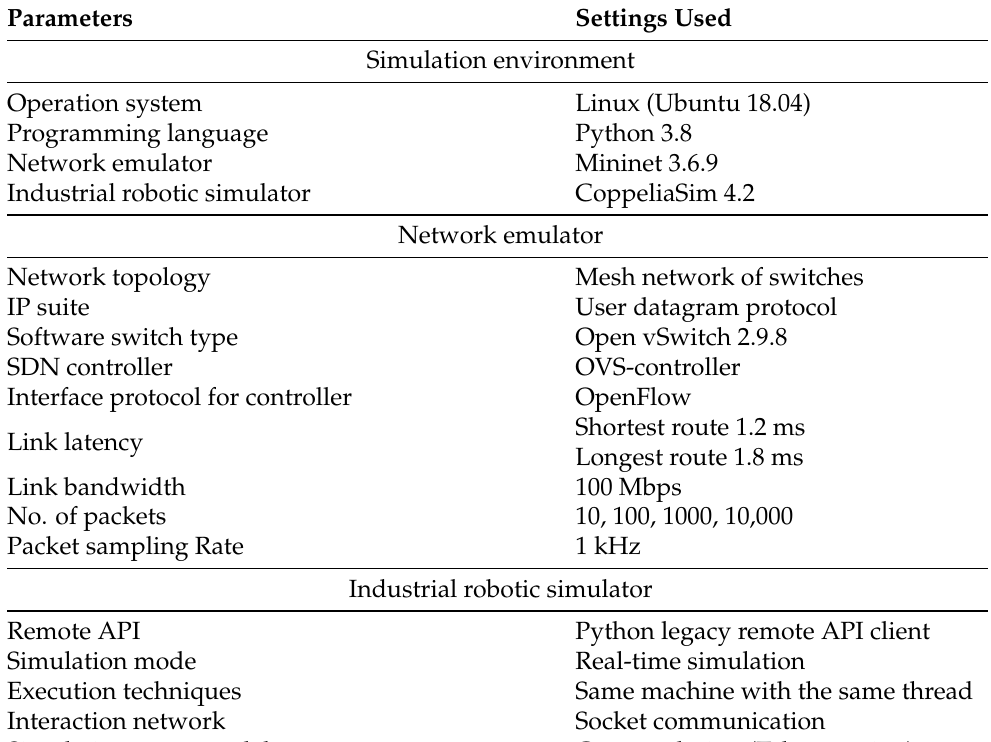
Table 2. Summary of parameters and settings used for